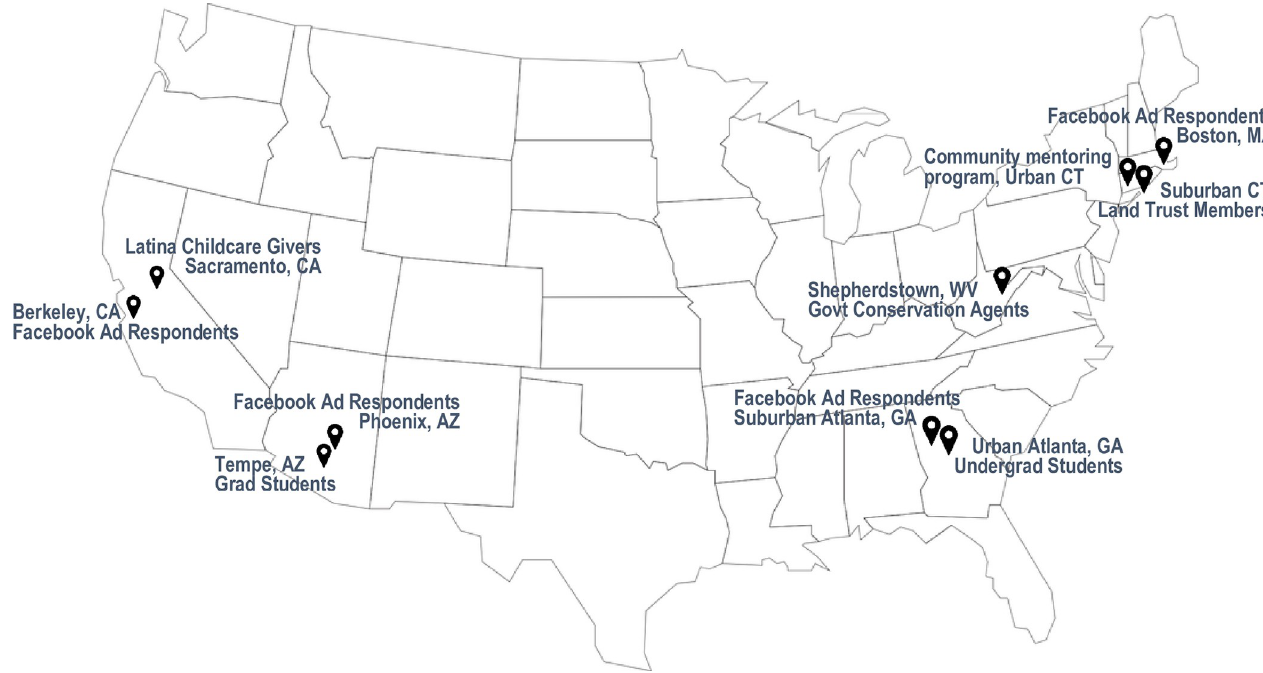
Fig 2. Focus group locations. Ten focus groups were held in four metropolitan regions and at a national conference of federal conservation officials. U.S. map is made available under the Creative Commons CC0 1.0 Universal Public Domain Dedication.